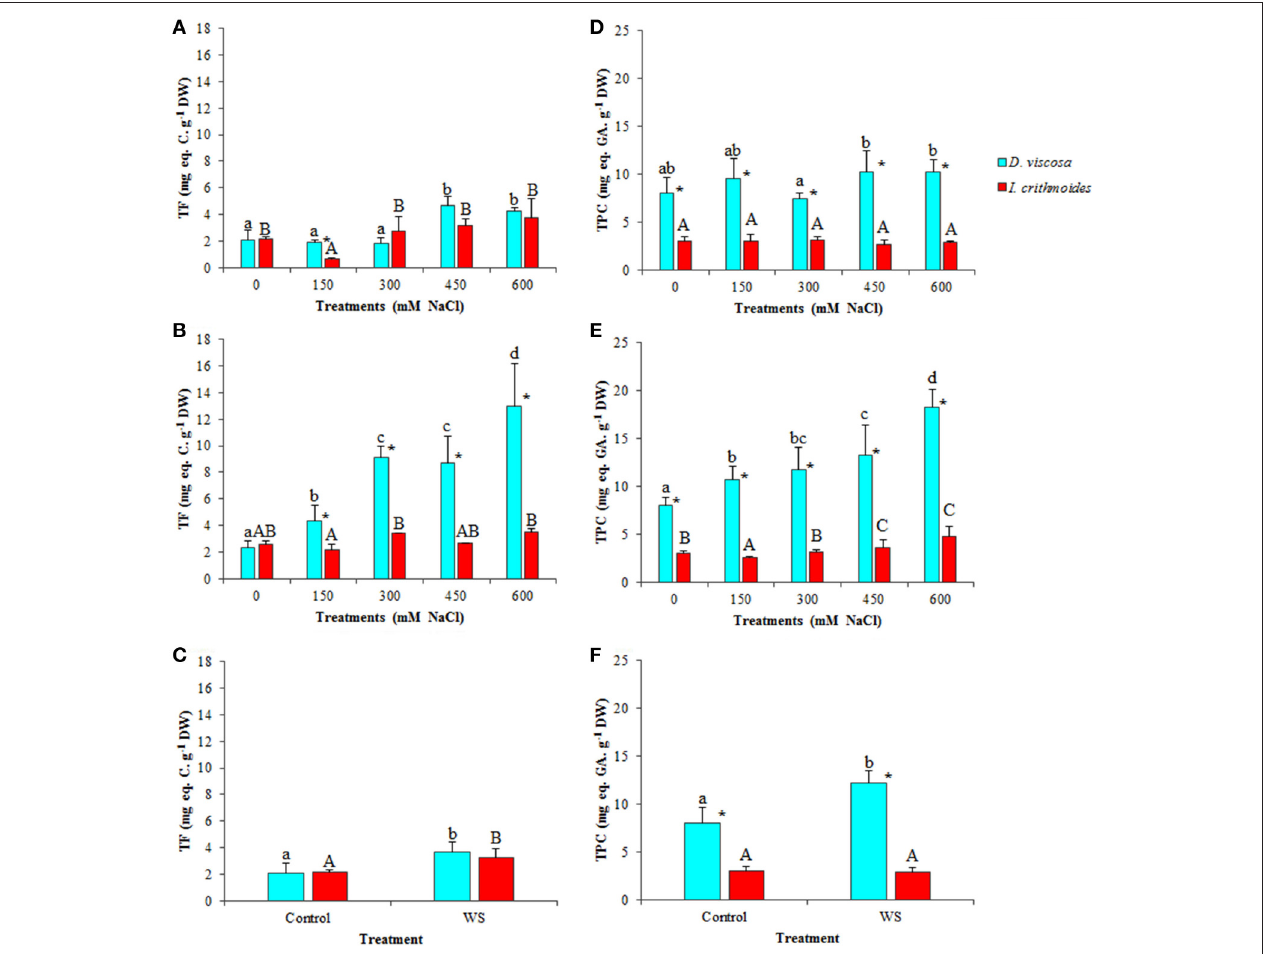
FIGURE 7 | Total flavonoids (TF) and total phenolic compounds (TPC) accumulation in leaves of D. viscosa and I. crithmoides stressed plants. TF (A–C) and TPC (D–F) contents after 3 weeks (A,D) and 6 weeks (B,E) of treatment with the indicated NaCl concentrations, or after 3 weeks of water stress (C,F) . Values shown are means ± SD ( n = 5 ). Different letters (lowercase for D. viscosa and capital letters for I. crithmoides ) over the bars indicate significant differences between treatments for each species according to Tukey test ( α = 0.05). Asterisks ( * ) indicate significant differences between the two species for the same